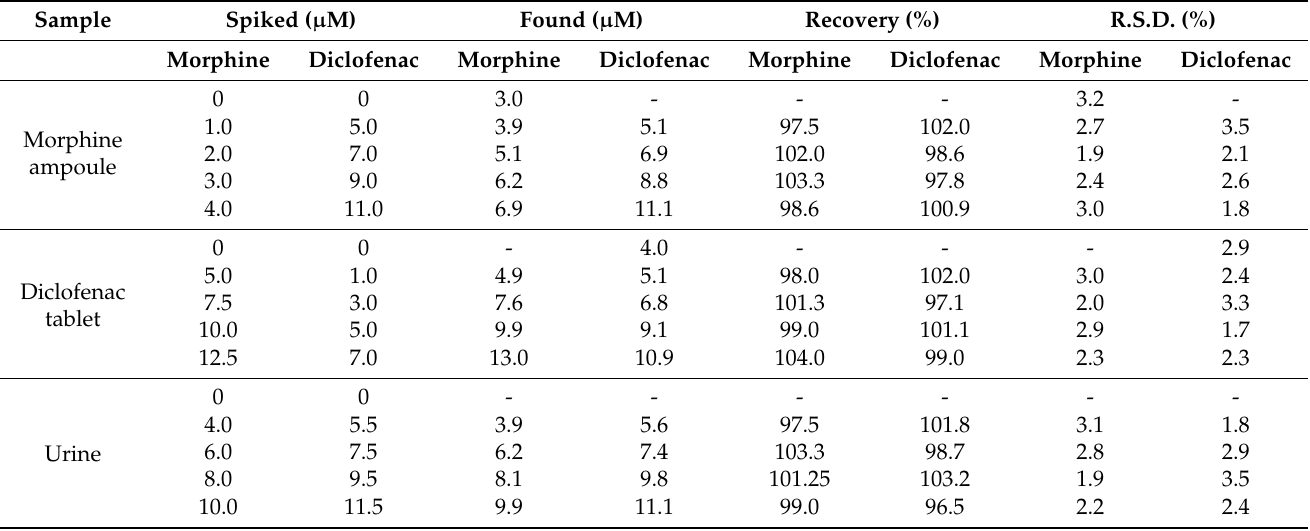
Table 2. Voltammetric sensing of morphine and diclofenac in real specimens using graphene- Co 3 O 4 /SPGE. All concentrations are in µ A (n =